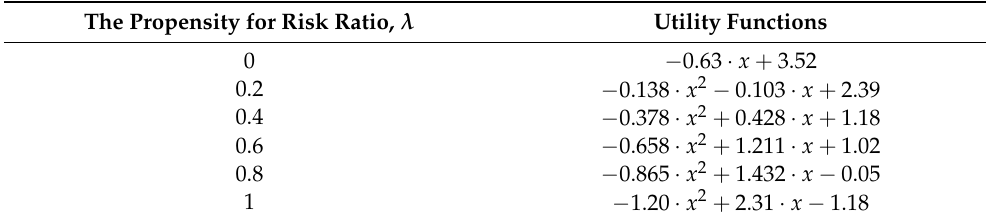
Table 1. The utility functions of the project group employees from Energoatom’s systems integration department in terms of their propensity for risk while obtaining the material remuneration. The Propensity for Risk Ratio, λ